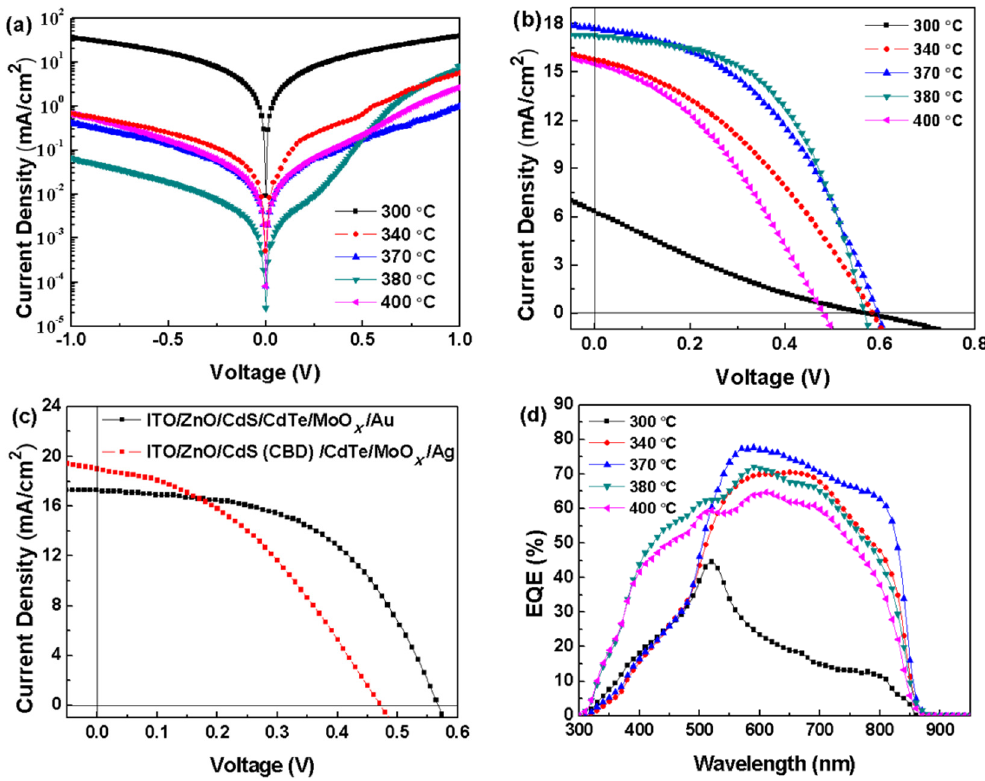
Figure 6. J – V curves of CdTe/CdS NC solar cells with different annealing temperatures ( a ) under dark and ( b ) under light; ( c ) the comparison of CdTe/CdS solar cells with CBD–CdS or CdS NCs as window layers; and ( d ) the resultant EQE spectra. Table 3. Summarized performance of CdTe/CdS NC solar cells with different annealing temperatures (Figure 6).